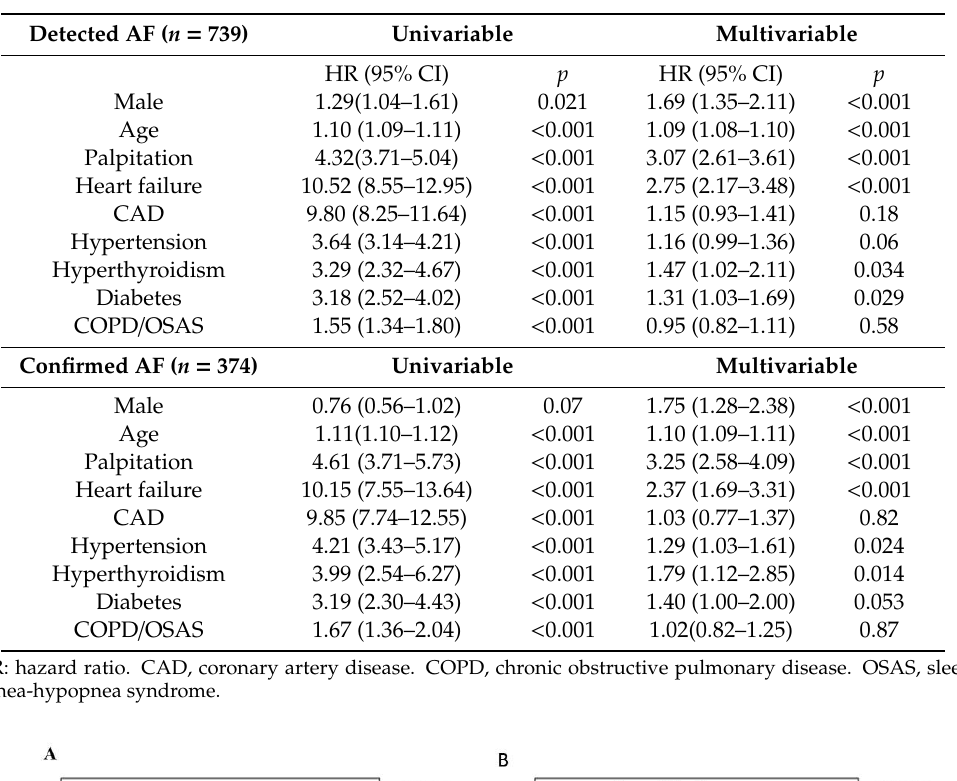
Table 5. Univariable and multivariable hazard ratios for detected AF in 209,274 subjects.